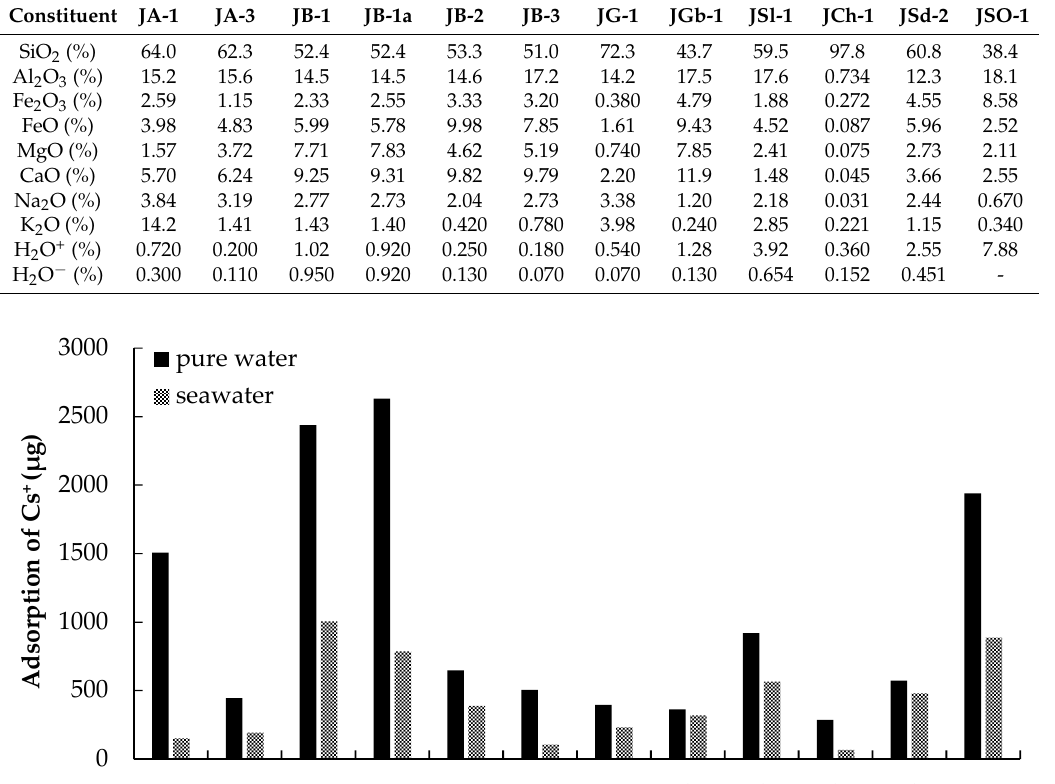
Figure 2. Adsorption quantity of Cs + onto the natural Japanese rocks (0.5 g) with pure water or seawater. Initial Cs + concentration: 200 mg/L.